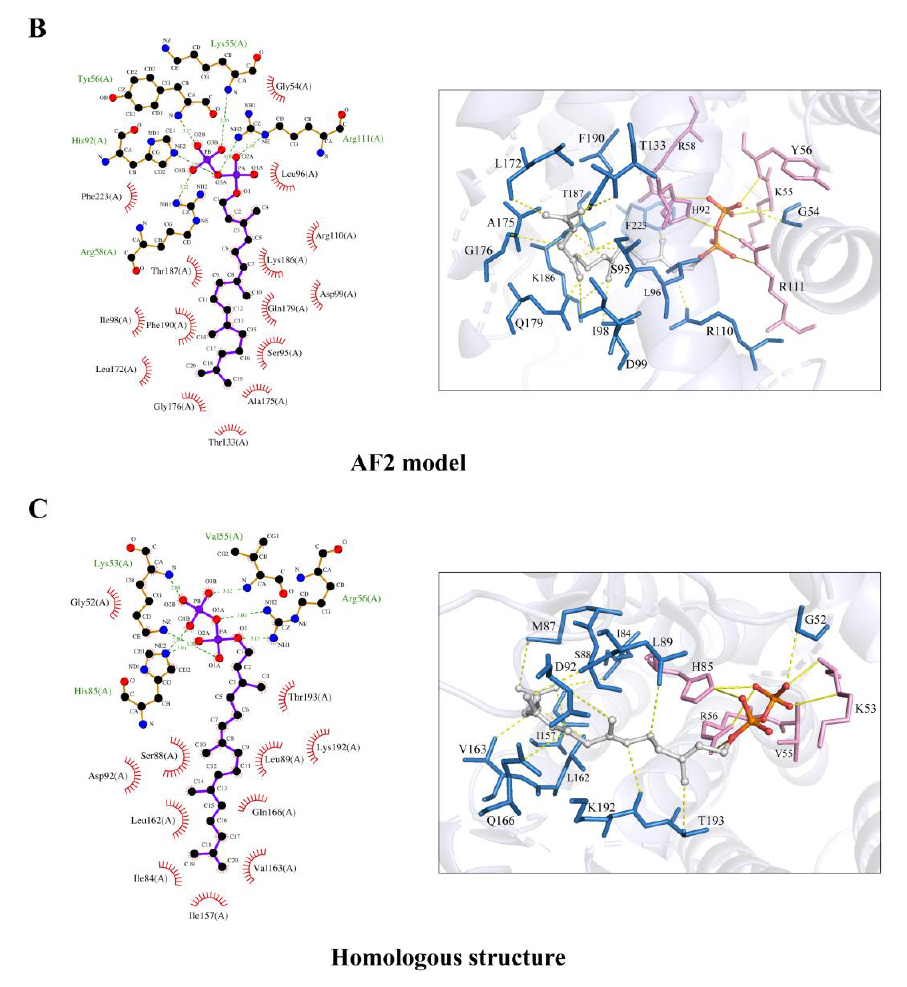
Figure 7. Schematic diagrams of the detailed interactions between the B318L protein and GGPP simulated with molecular docking. ( A – C ) Visualization of the detailed molecular interaction of GGPP with the B318L crystal structure ( A ), the AF2 predicted model ( B ), and the 2J1P homologous structure ( C ), respectively. In the left panels, all GGPP molecules and residues for hydrogen-bonding interactions are displayed as stick-ball models and the hydrogen bonds are marked by green dashed lines. All residues for hydrophobic interactions are also labeled and shown as eyebrow symbols. In the right panels, all GGPP molecules are displayed as stick-ball models in gray. Residues for hydrogen-bonding interactions are displayed as stick models in pink and the hydrogen bonds are marked by yellow solid lines. Residues for hydrophobic interactions are displayed as stick models in